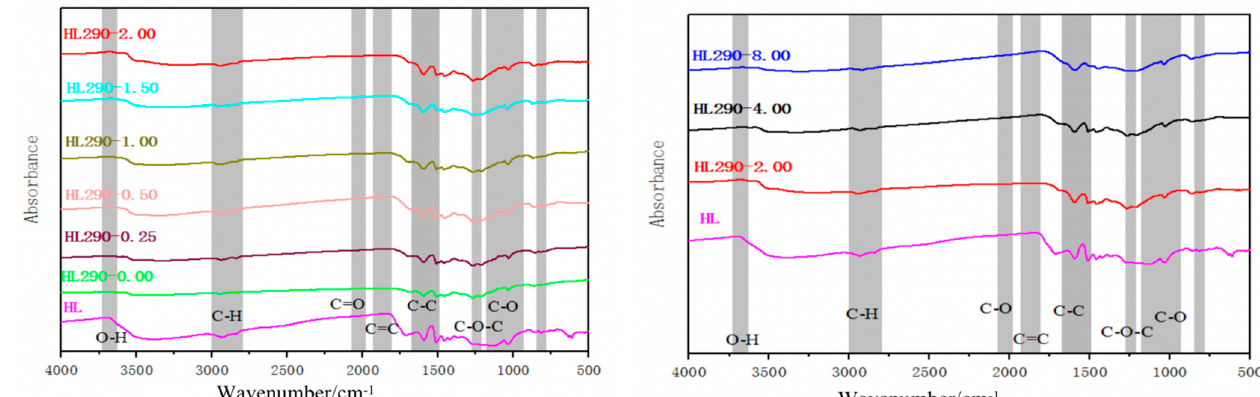
Figure 2. Infrared spectra of lignin and its hydrothermal carbon at different holding times.